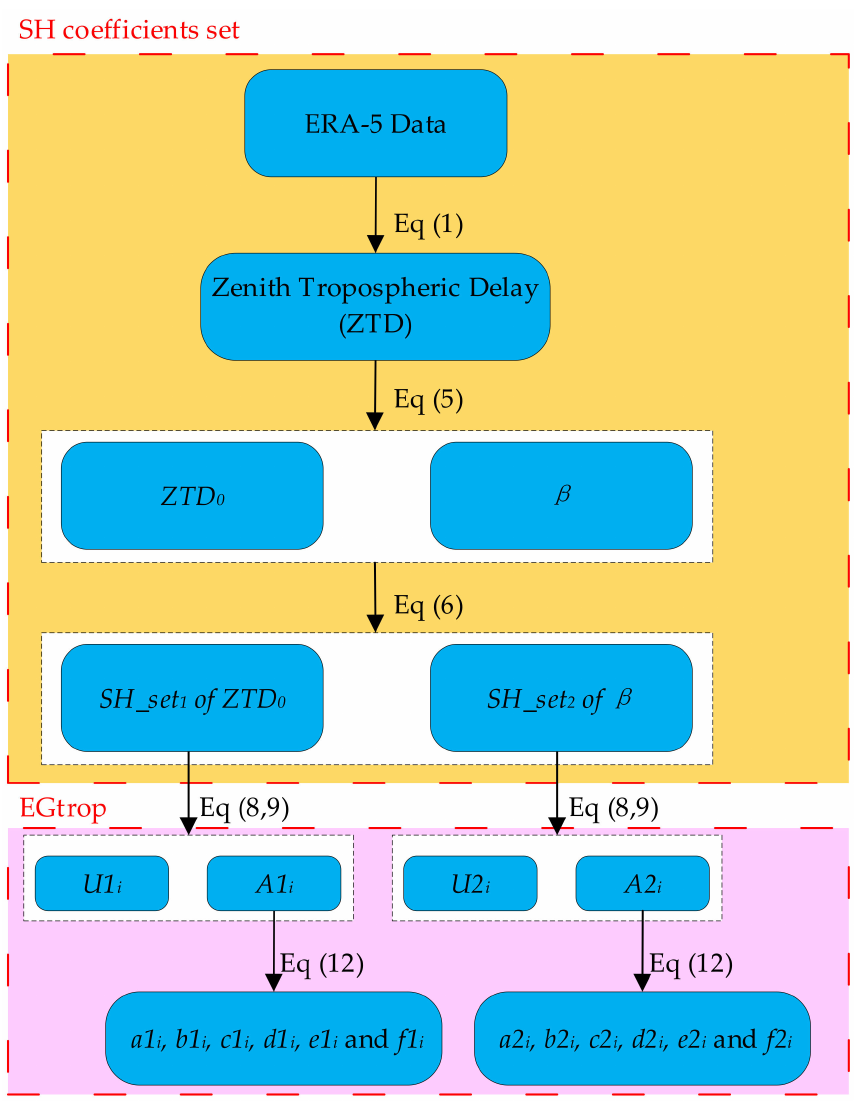
Figure A1. Flowchart of EGtrop model